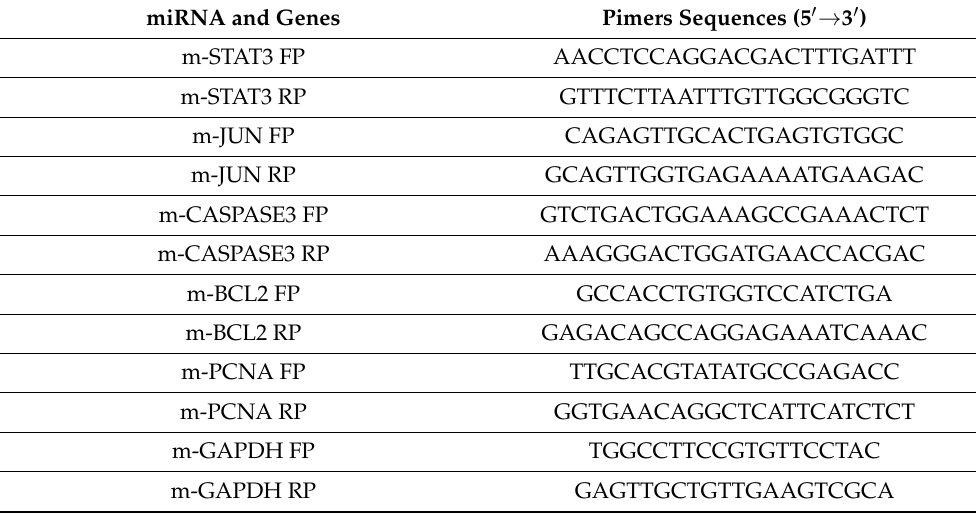
Table 3. Cont. miRNA and Genes Pimers Sequences (5 (cid:48) → 3 (cid:48)